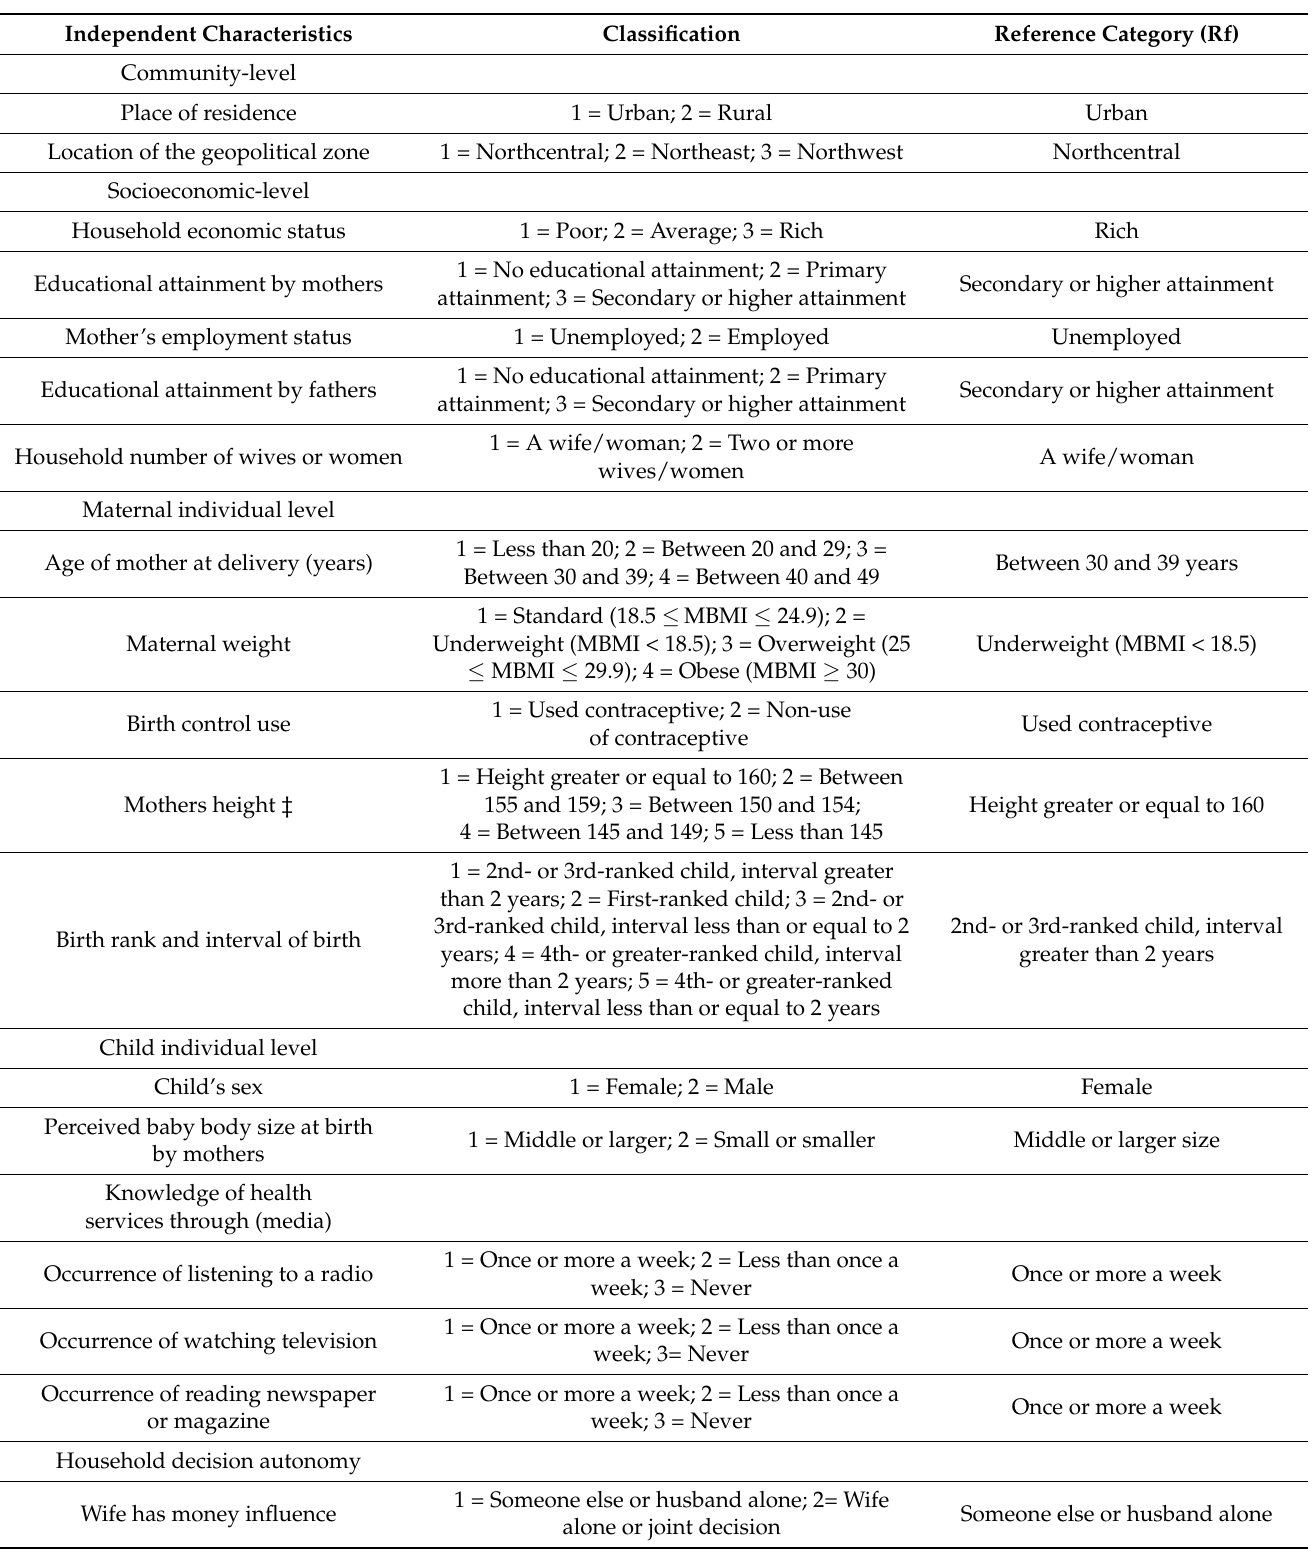
Table 1. Classification and description of likely independent confounding related characteristics to underweight in children below 60 months old for the study